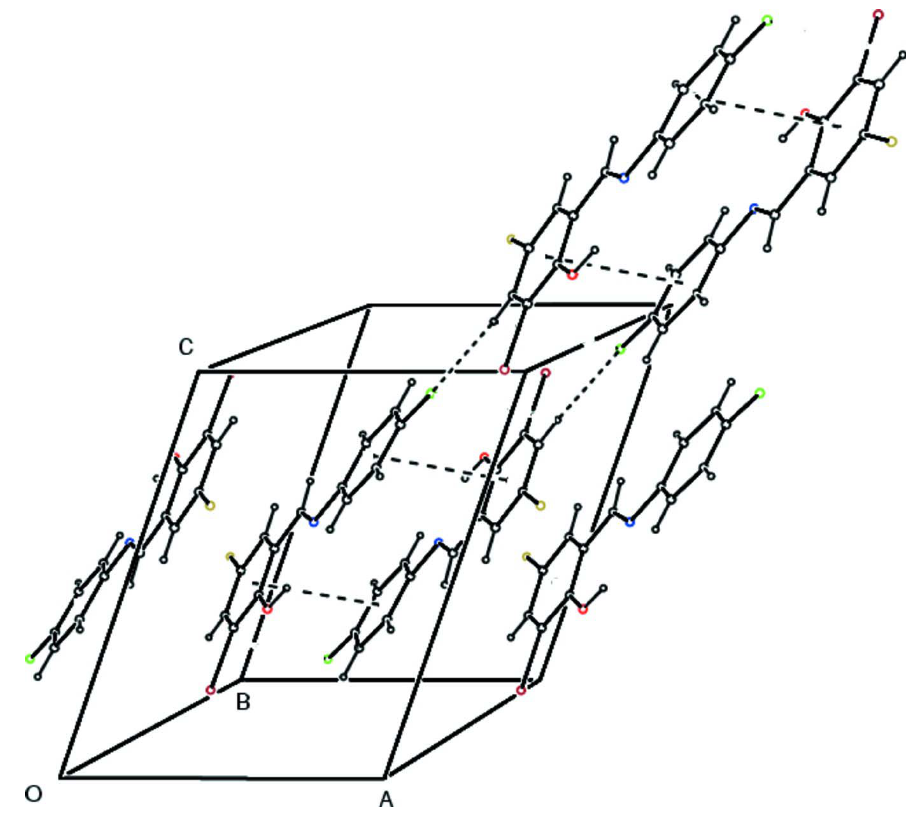
Figure 2 Packing of molecules in the unit cell. Intermolecular interactions are shown with dashed